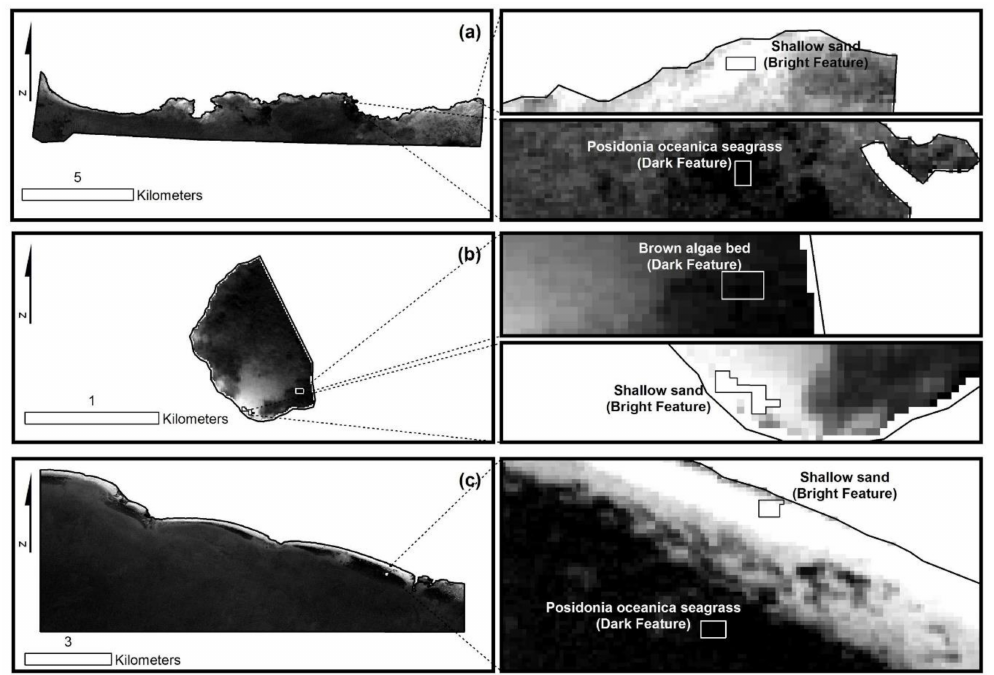
Figure 3. Location of used pseudo-invariant features (zoomed right panels) in the normalisation of the Apokoronas and Thermaikos composites ( b , c ) to the National Samaria Park composite ( a